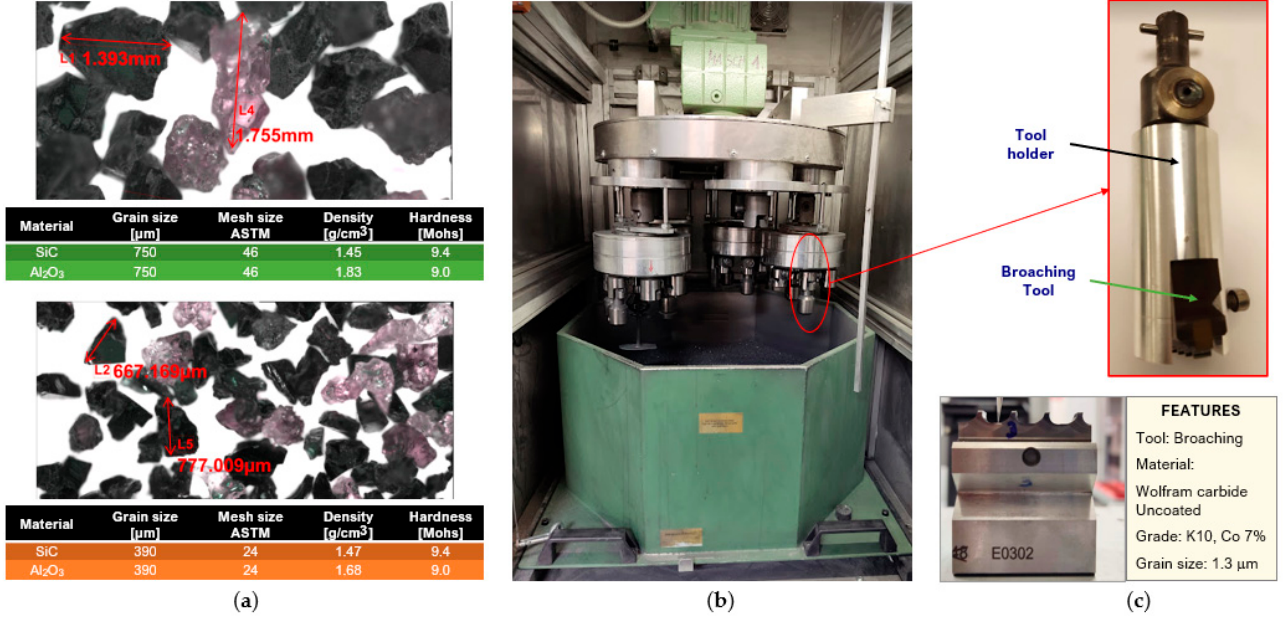
Figure 1. Drag finishing process: ( a ) microscope images of abrasive particles and characteristic, ( b ) drag finishing machine, and ( c ) broaching tool.